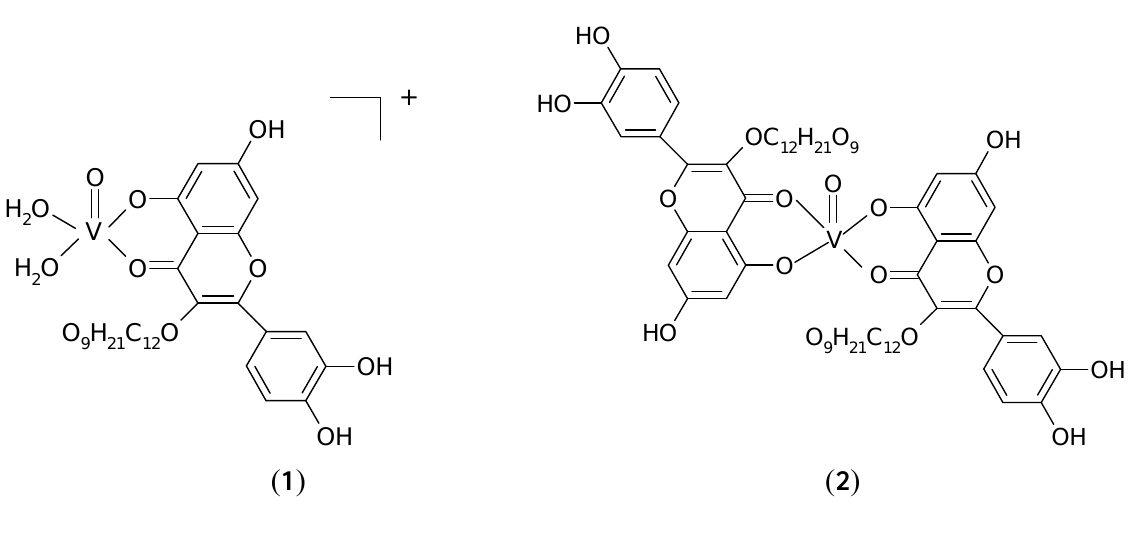
O) ] + ( 1 ) and [VO(Rut) 2 2